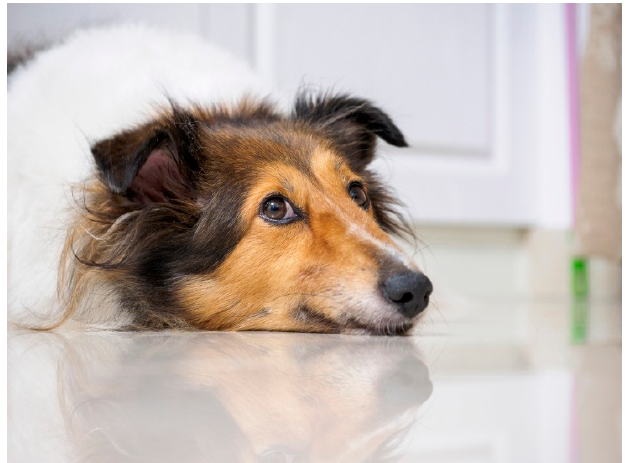
Figure 1. Source: Shutterstock, 473159719.